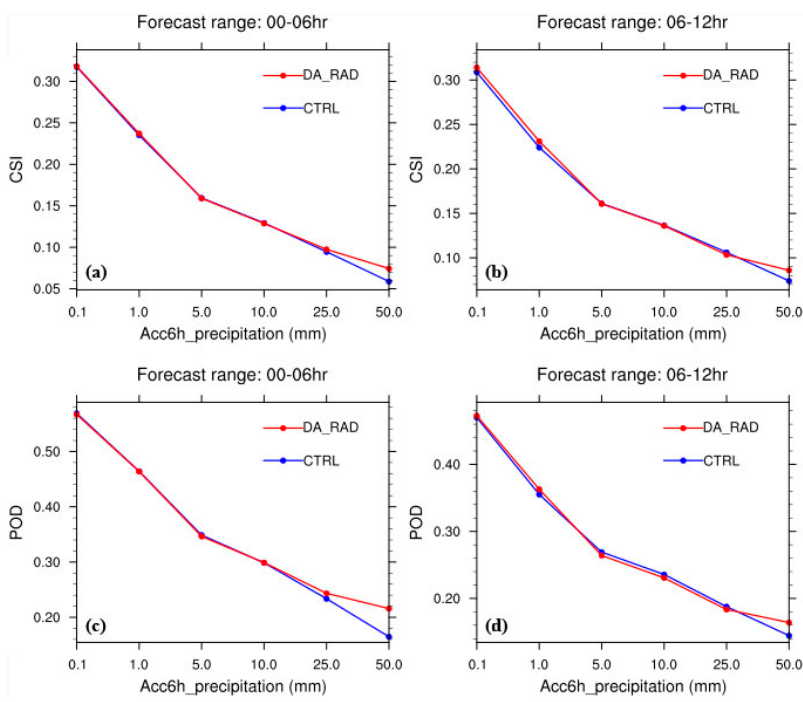
Figure 14. The average CSI ( a , b ) and POD ( c , d ) for the 6-h accumulated precipitation in Domain 2 for different thresholds in the first 12 h of the forecasts.